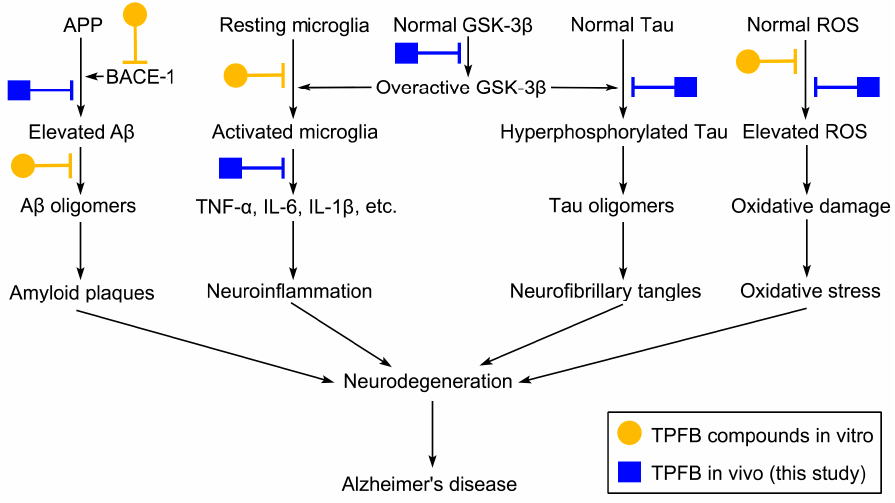
Figure 5. Schematic diagram illustrating major Alzheimer’s disease (AD) pathological pathways and the potential targets of TPFB in this study and its major components in previous studies [12,13,30–34]. ROS: reactive oxygen species. A β : amyloid β -peptide.